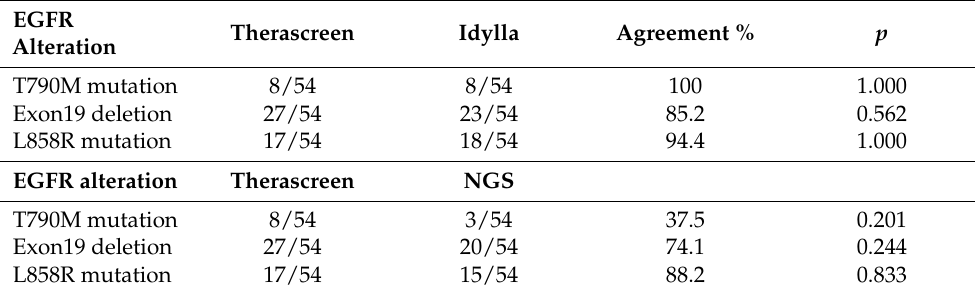
Table 5. Comparisons between Therascreen ® , Idylla™, and NGS in detecting the most clinically relevant EGFR gene alterations in ctDNA